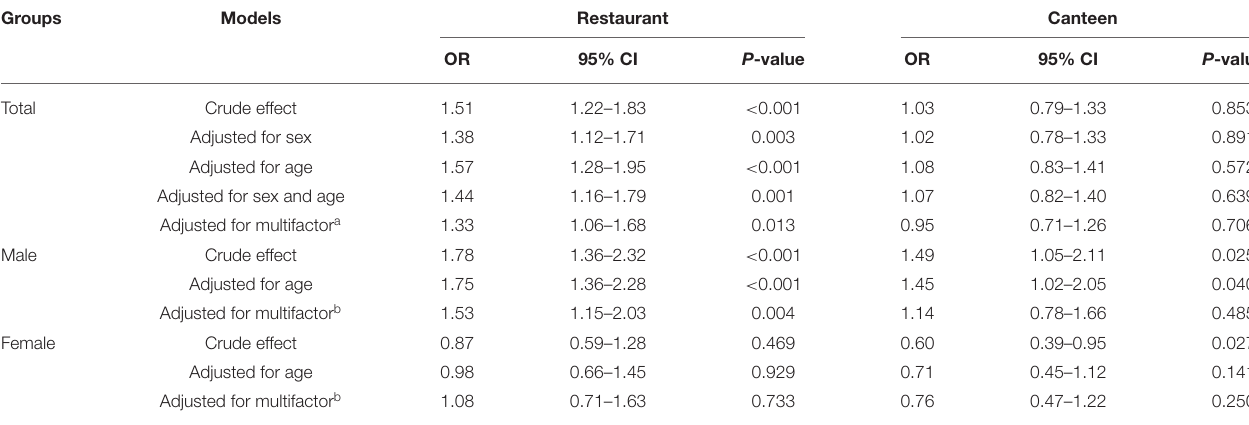
TABLE 4 | Association between eating away from home and risk of high serum uric acid regarding restaurant and canteen. Groups Models Restaurant Canteen OR 95% CI P -value OR P -value